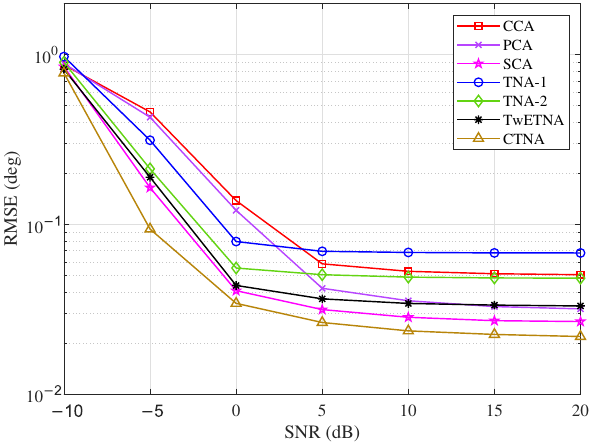
Figure 7. RMSE versus SNR, where T = P = 800, | c 1 | = 0.2. The RMSE curves versus the number of snapshots varying from 200 to 2000